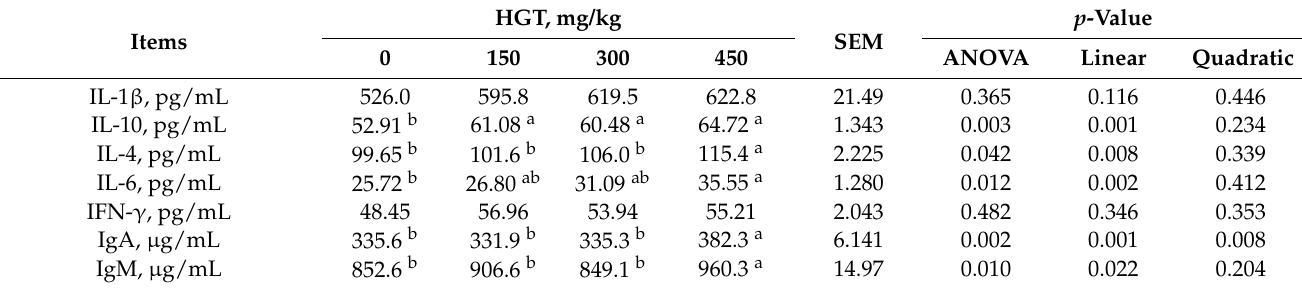
Table 6. The effect of HGT on serum immune-related factors of broilers 1